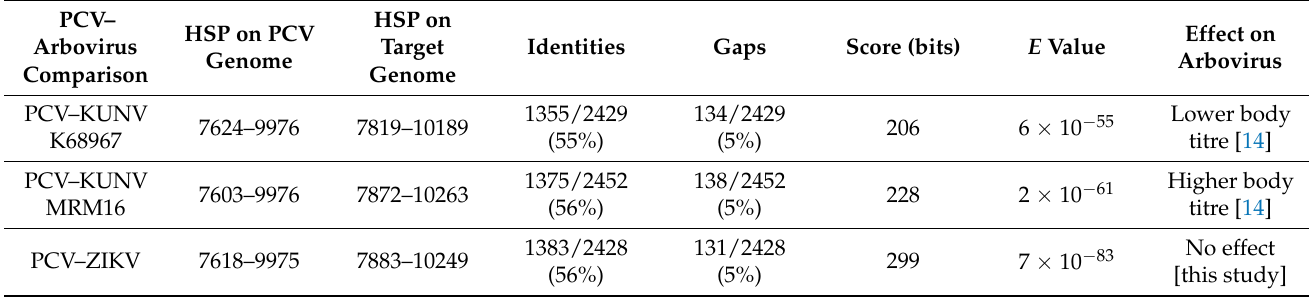
Table 1. Summary of BLASTn comparisons between the genomes of Palm Creek virus (PCV), West Nile virus, Kunjin subtype (KUNV isolates MRM16 and K68967), and Zika virus (ZIKV). HSP; high similarity pair. ISV–arbovirus interference is not predicated on genome sequence